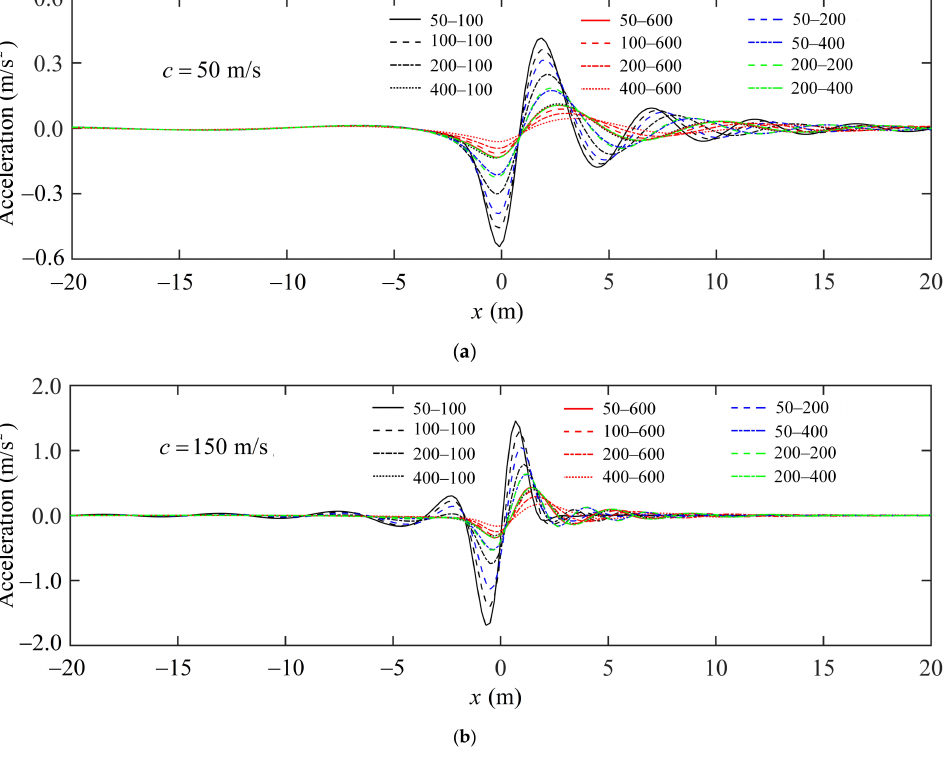
Figure 14. Effect of layer thickness on the vertical acceleration fluctuation amplitude along the x -axis, induced by a moving Gaussian load with speeds of ( a ) c = 50 m/s and ( b ) c = 150